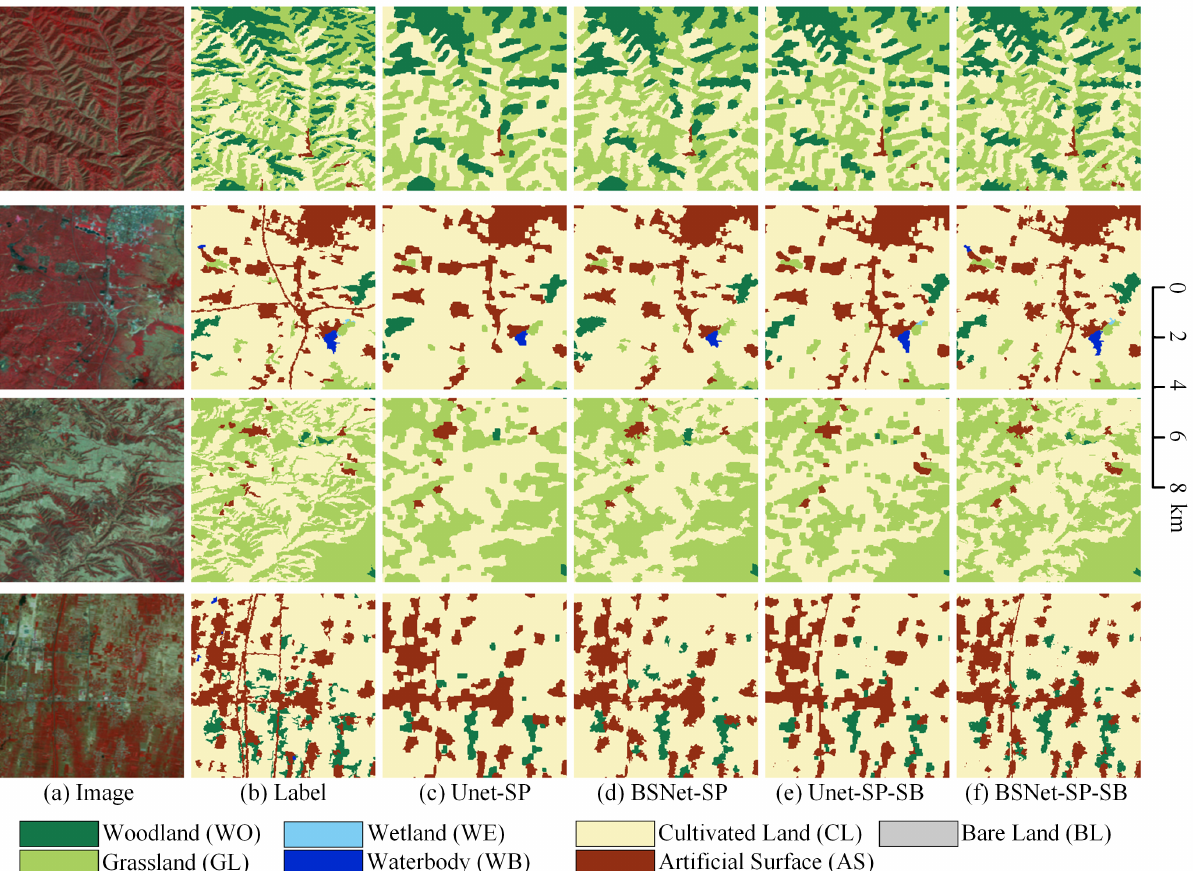
Figure 11. Ablation study with the self-boosting method on Landsat core dataset. ( a ) Landsat image. ( b ) Ground truth. Inference result of ( c ) the UNet with the superpixel branch (UNet-SP), ( d ) the UNet-SP with the self-boosting method (UNet-SP-SB), ( e ) the BSNet with the superpixel branch (BSNet-SP), and ( f ) the BSNet-SP with the self-boosting method